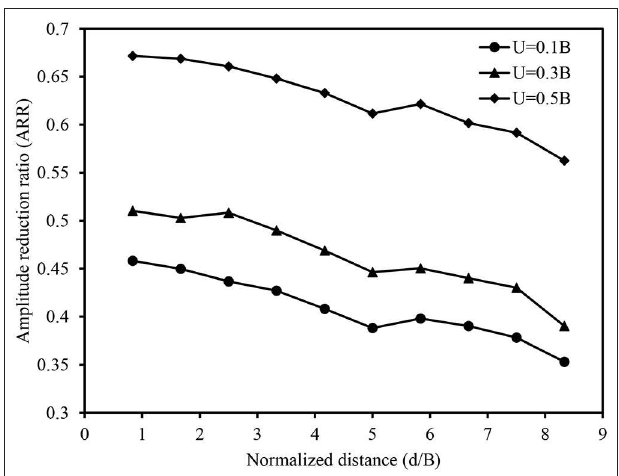
FIGURE 4 | Variation of ARR with the normalized distance.